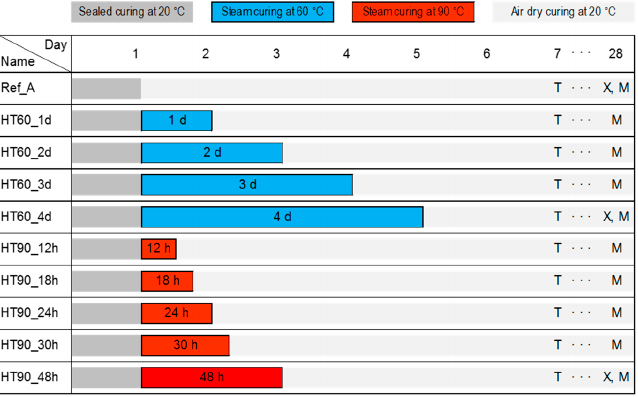
Figure 2. Curing and testing program of UHPC samples (T, X, and M denote the test days for Thermogravimetric Analysis (TGA), X-ray Diffraction (XRD), and mercury intrusion porosimetry (MIP), respectively).